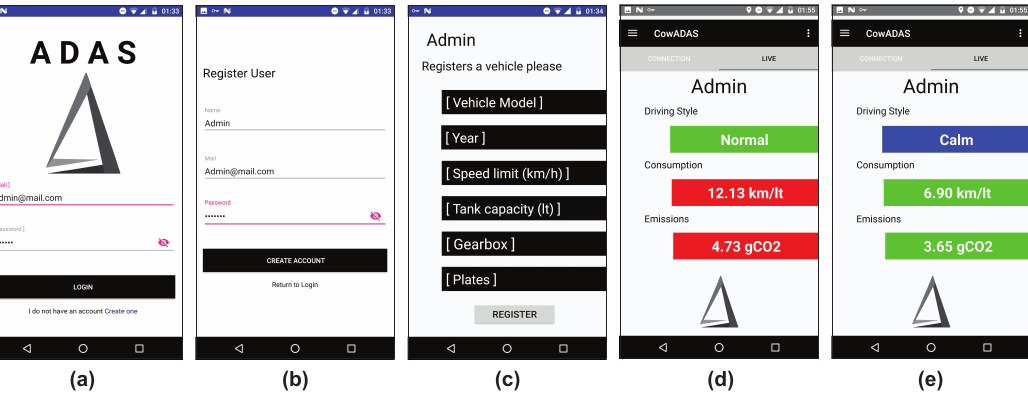
Figure 17. Mobile application of the proposed human–vehicle interaction monitoring system: ( a ) login interface, ( b ) create account interface, ( c ) vehicle specifications interface, ( d , e ) examples of the monitoring system in